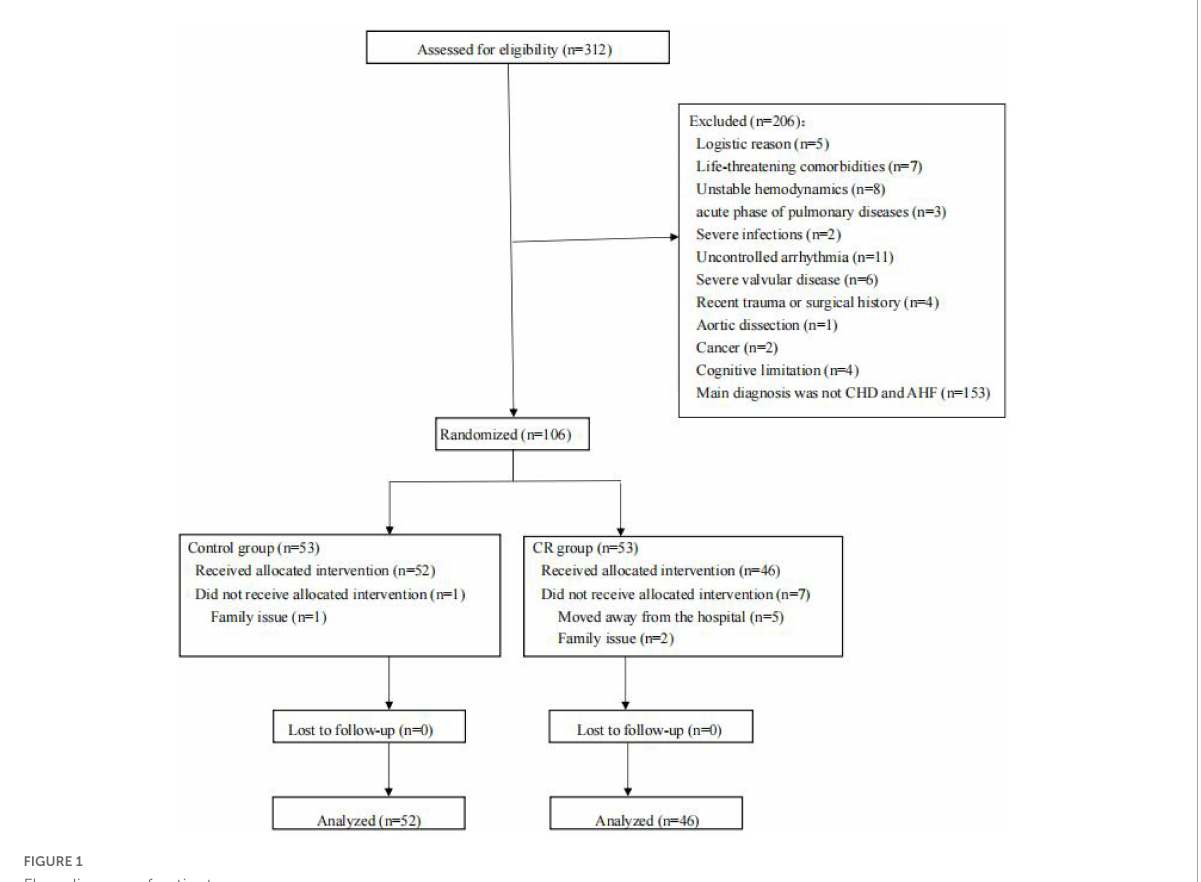
FIGURE1 Flow diagram of